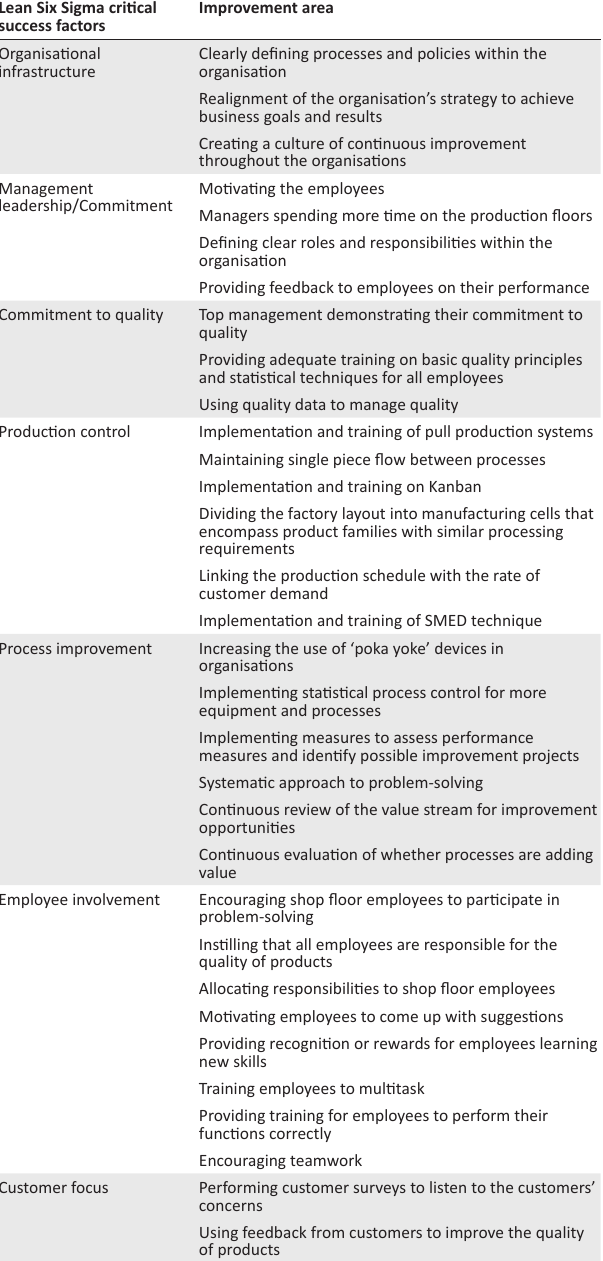
TABLE 10: Improvement areas for Lean Six Sigma